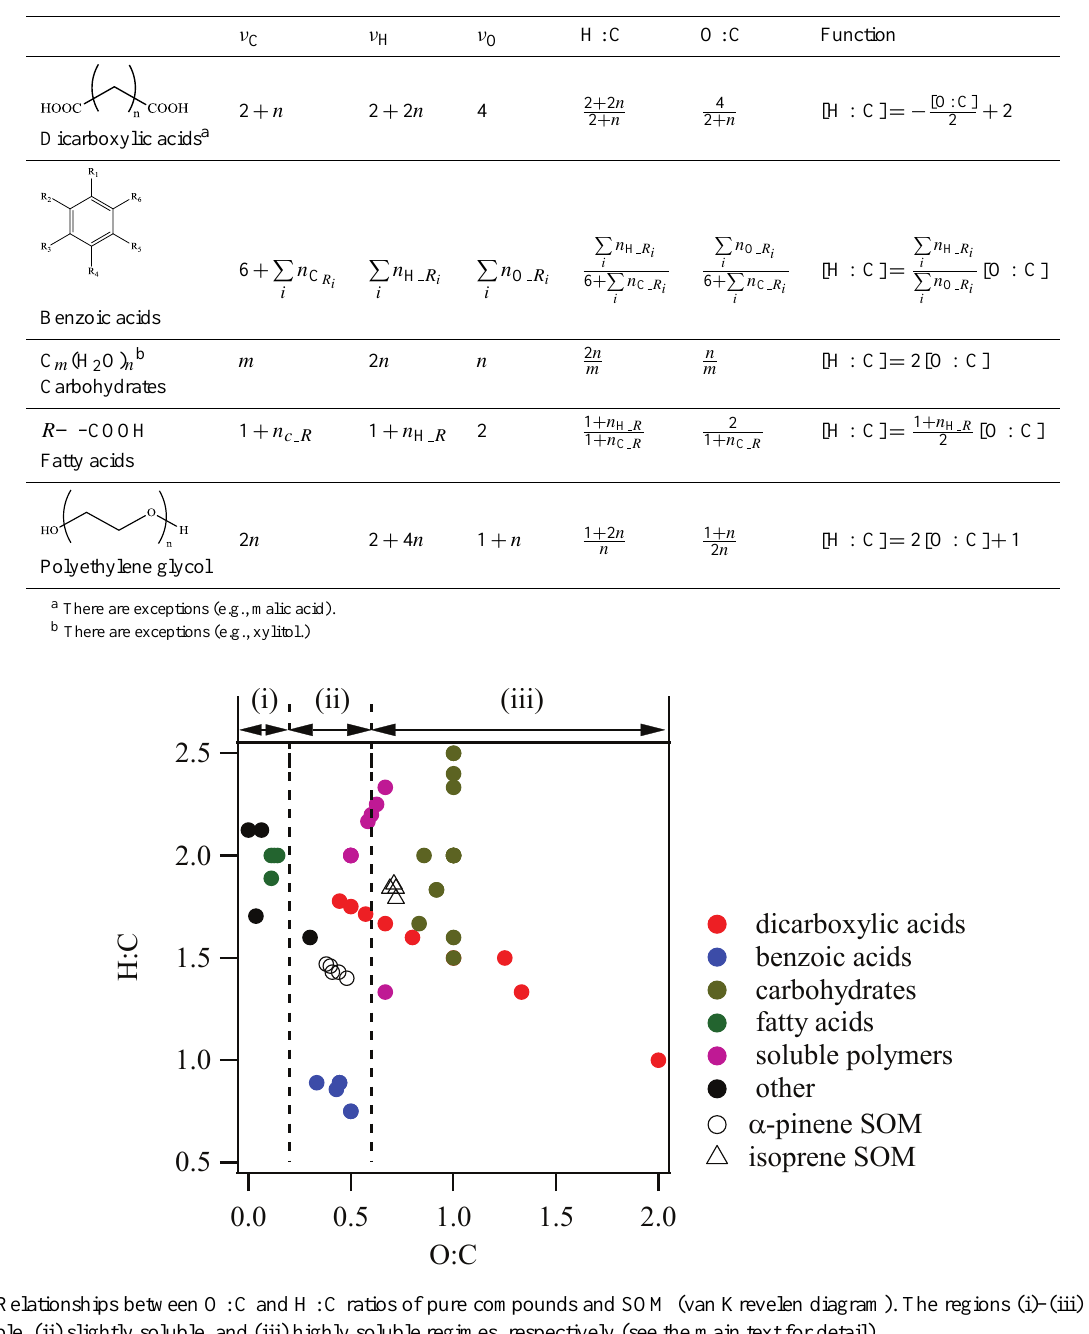
chain. H : C ratios for those compounds are also similar to aliphatic compounds. Polyethylene glycol was employed as an example for synthetic polymers (Petters et al.,